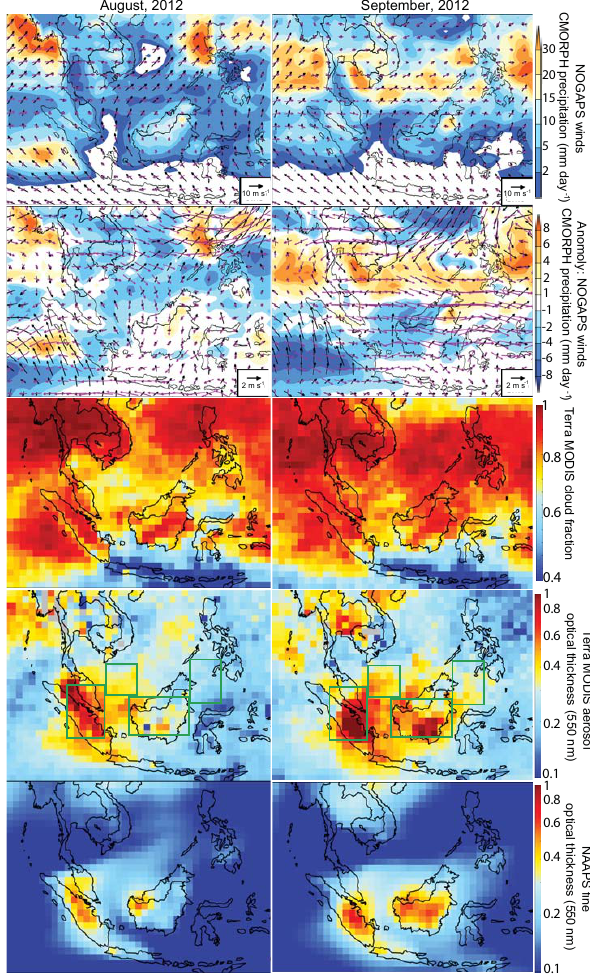
Figure 3. August and September 2012 averages of key fields to represent the overall nature of the southwest monsoon during the 7SEAS intensive. Included are NOGAPS surface (black) and 700hPa (magenta) winds overlaid on average CMORPH-derived rain rate; monthly anomalies of likewise data; Terra MODIS mean day and night cloud cover; Terra MODIS C6 average 550nm aerosol optical thickness (AOT); and NAAPS reanalysis 500nm fine-mode